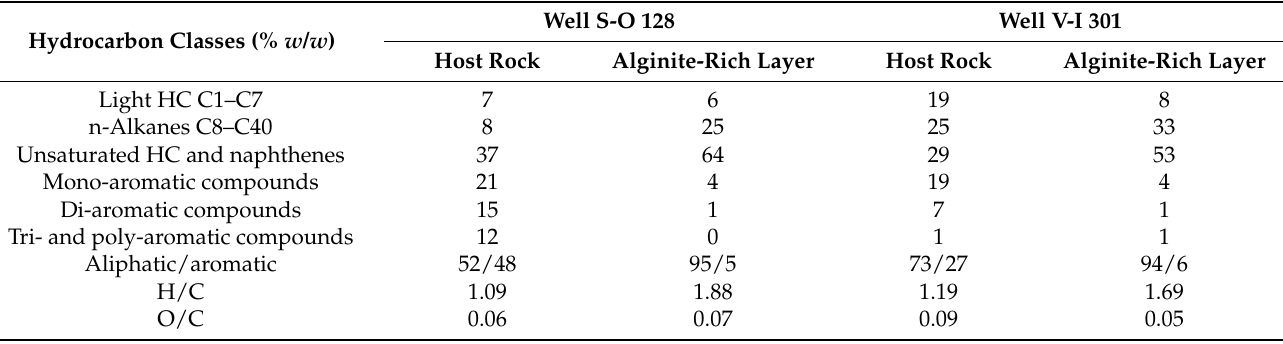
Table 2. Distribution of HC classes from Pyro-GC × GC-TOF MS/FID and elemental analysis data for the alginite-rich layers and host